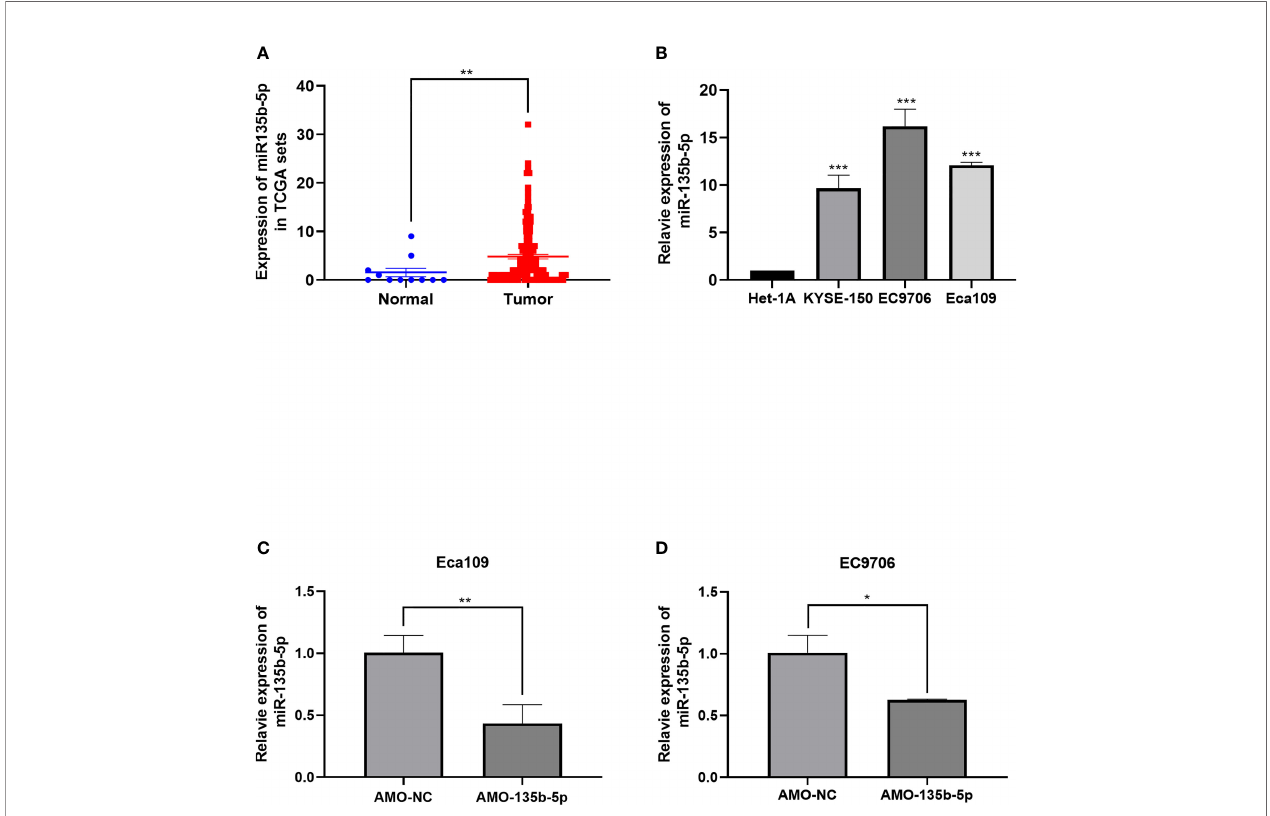
FIGURE 1 | Expression of miR-135b-5p in EC tissues and EC cells. (A) MiR-135b-5p expression was higher in EC patient tissues than normal tissues. (B) MiR- 135b-5p showed higher expression in Eca109, EC9706, KYSE150 cell lines than Het-1A cells. (C, D) Expression of miR-135b-5p with transfected AMO-135b-5p, AMO-NC are showed by real-time PCR. (*p < 0.05, **p < 0.01, ***p <